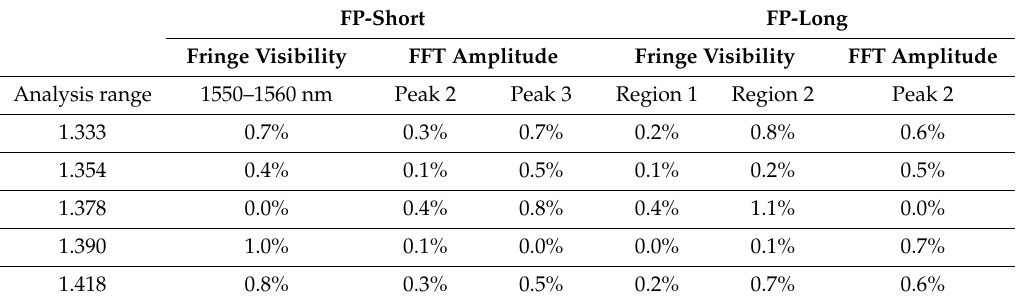
Table 3. Results of the di ff erences between refractive indices obtained through calibration (Abbe refractometer) and those obtained from the FP